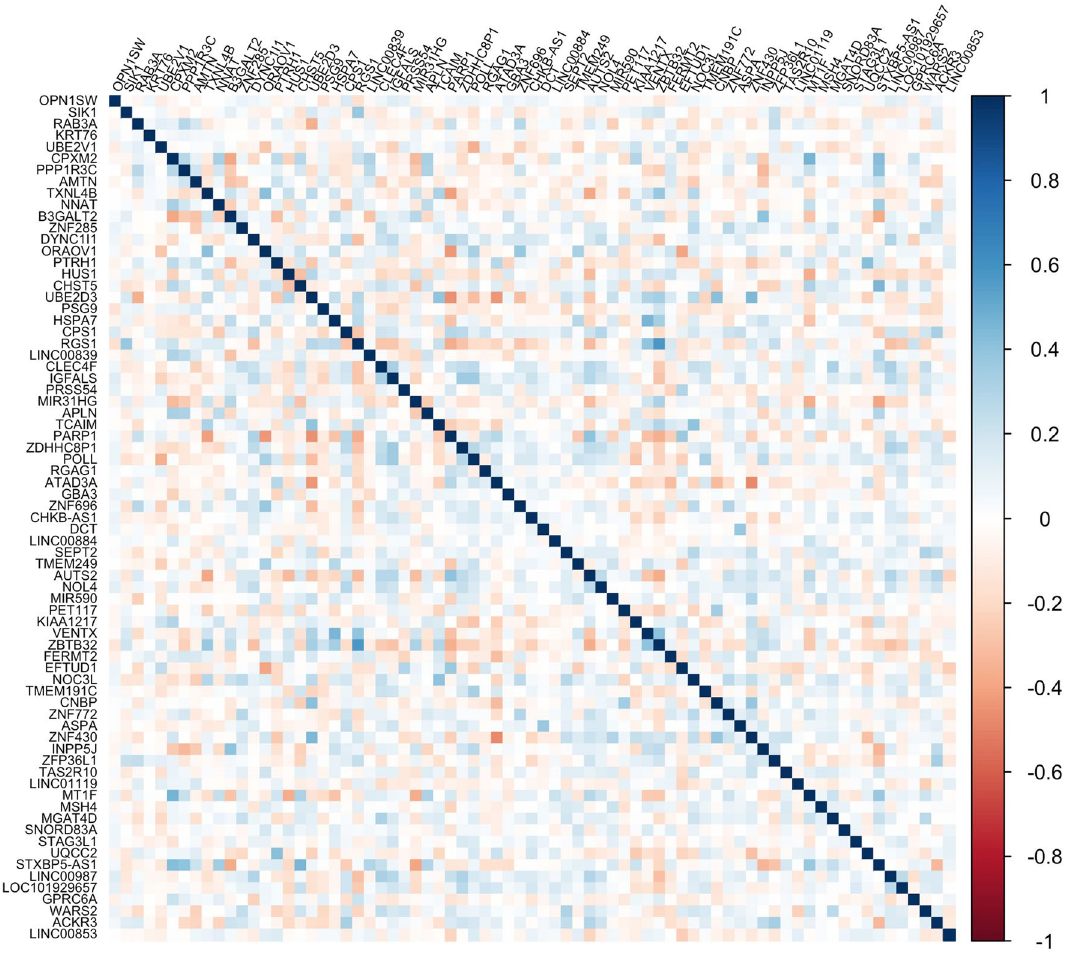
Figure 3. The heat map of the pair-wise Pearson correlation among the normalized and log-transformed gene expression values of 73